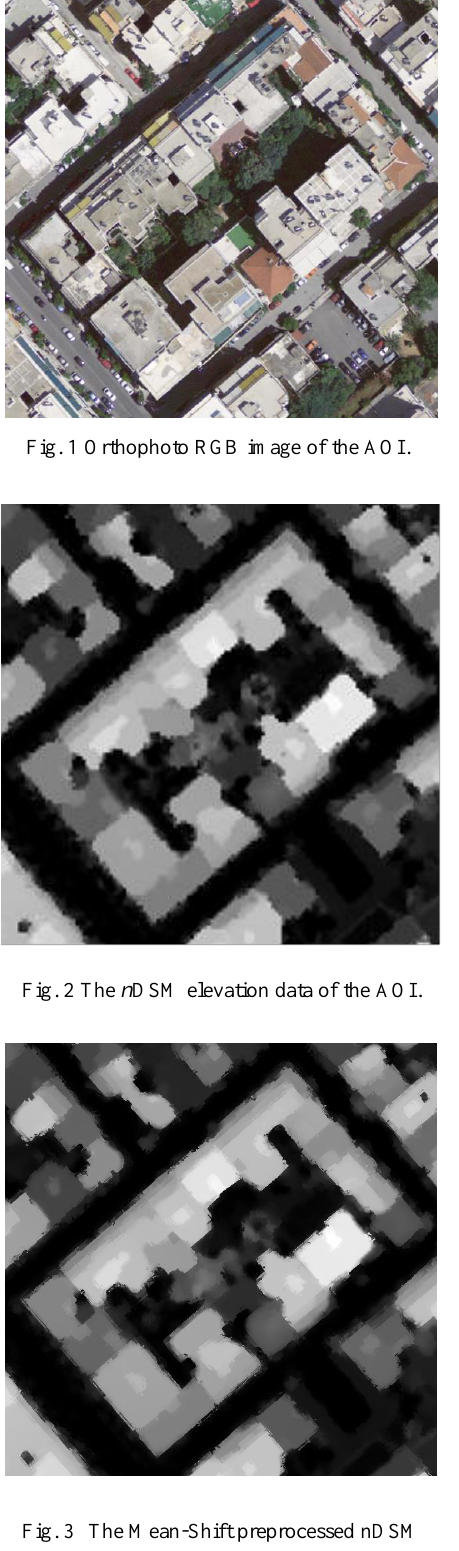
Fig. 3 The Mean-Shift preprocessed nDSM